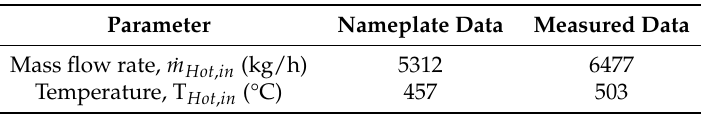
Table 2. Exhaust gases inlet